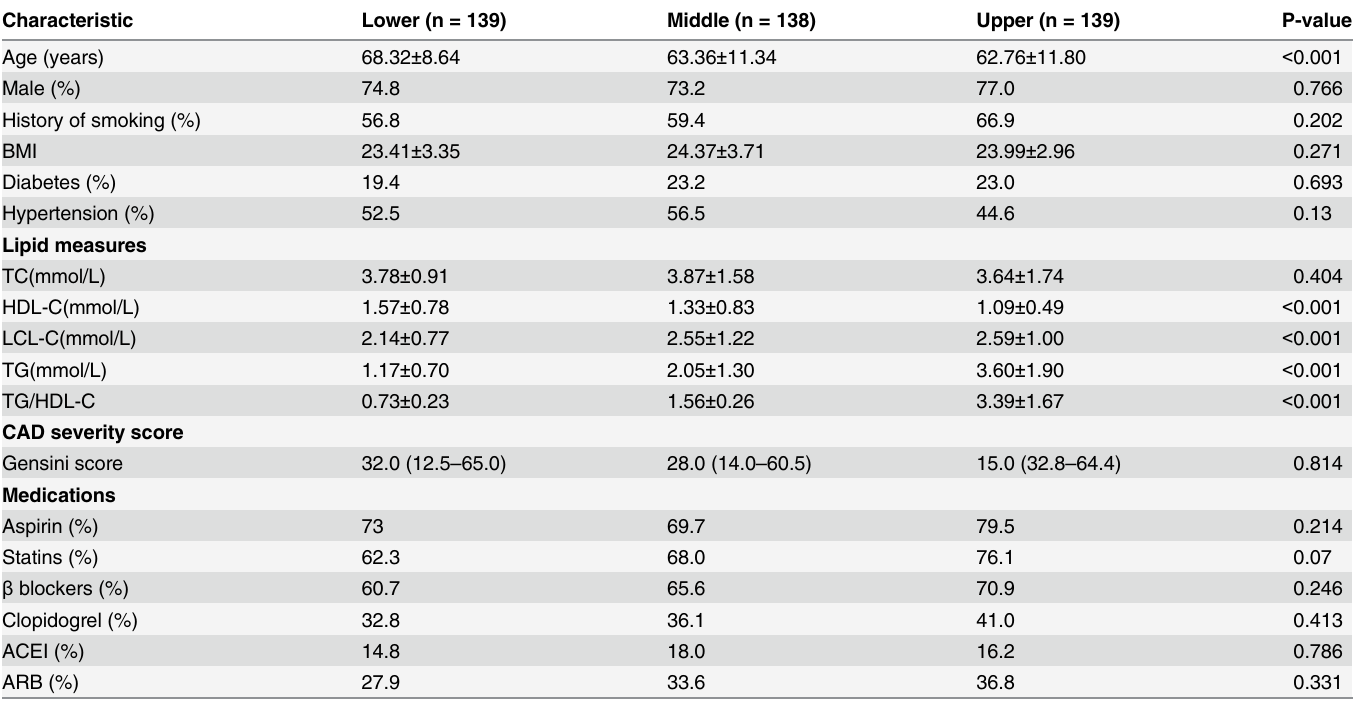
Table 1. Baseline characteristics according to the TG/HDL-C